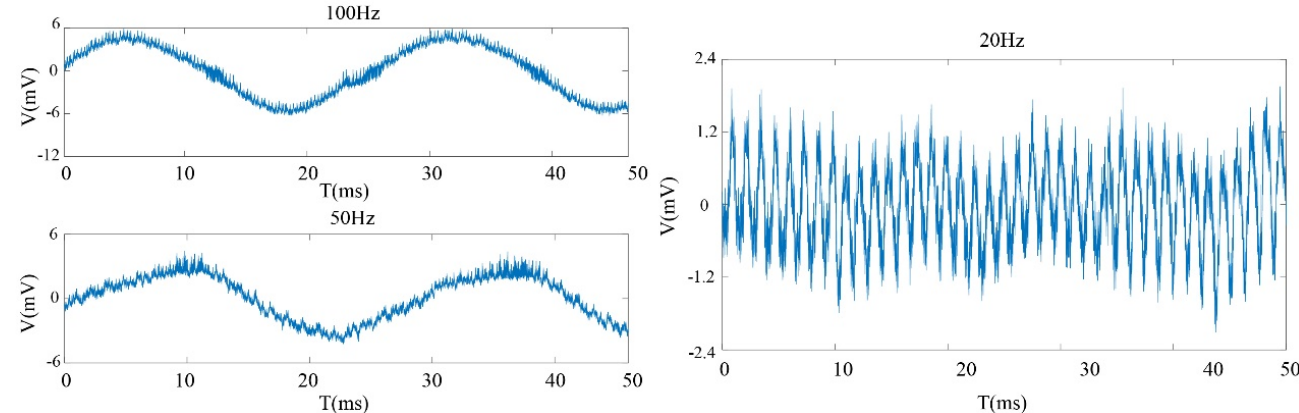
Figure 9. The responding curve of the sensor to acoustical signals of 100, 50, and 20 Hz.